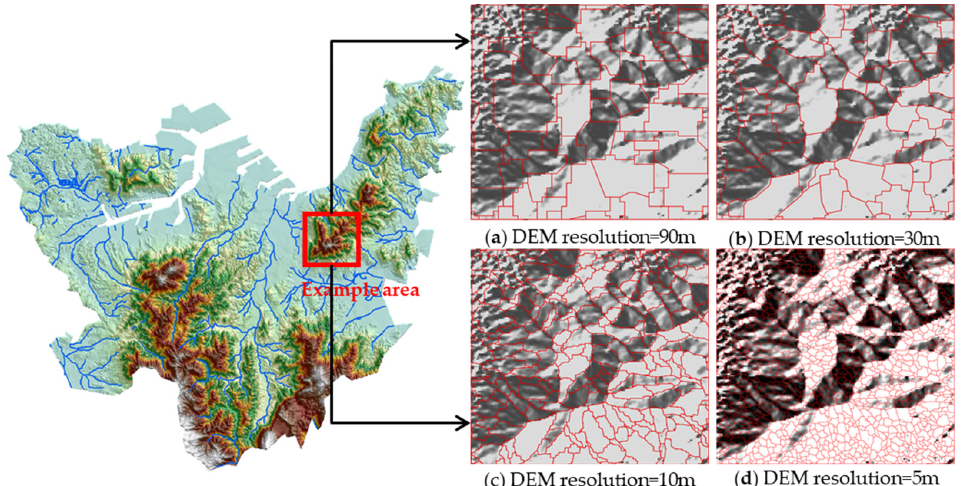
Figure 5. Example of slope unit subdivisions for a portion of the study area. Enlarging the “Example area” to illustrate the segmentation results obtained by the multiresolution segmentation method with different resolution data. Red lines show the boundaries of slope units, while gray areas are hill shade. ( a ) DEM resolution = 90 m; ( b ) DEM resolution = 30 m; ( c ) DEM resolution = 10 m; ( d ) DEM resolution = 5 m.